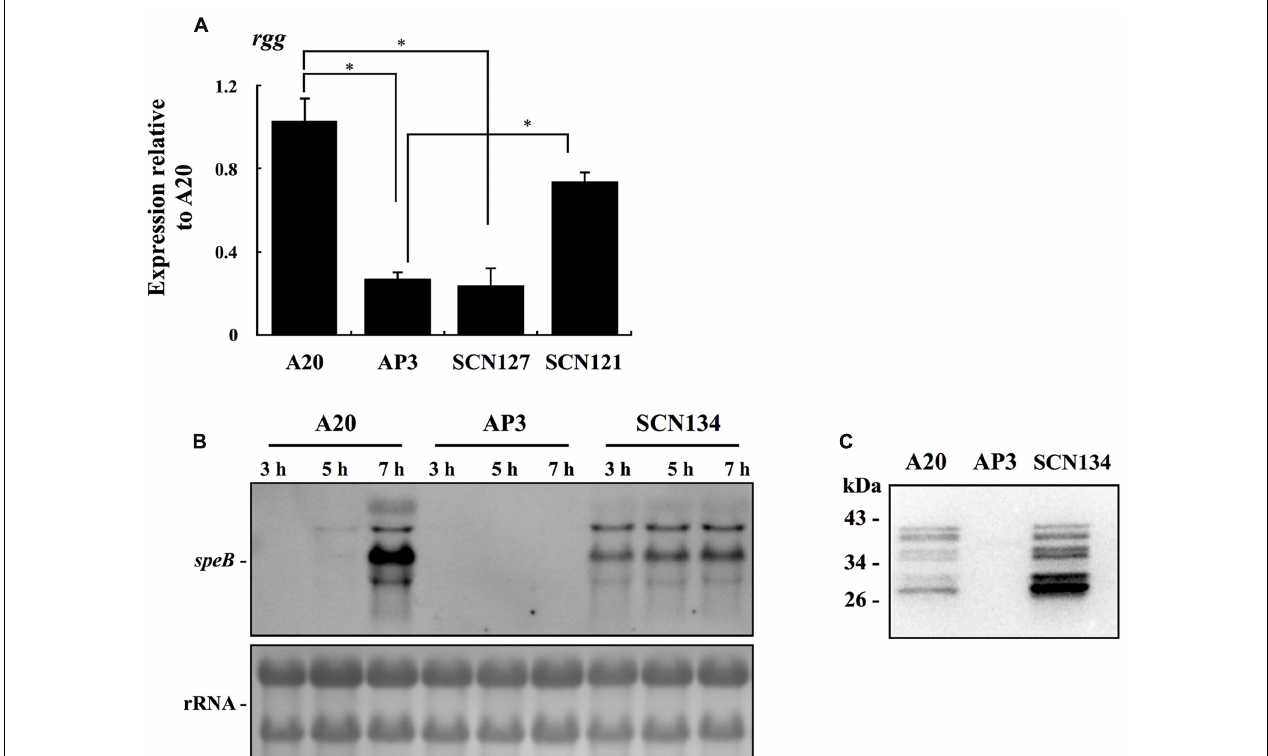
FIGURE 2 | The expression of rgg and speB in wild type A20 strain, covS mutant AP3, covR/S- complemented strain SCN121, vector control strain SCN127, and AP3 rgg overexpression strain SCN134. (A) The expression of rgg in A20, AP3, SCN127, and SCN121 in the stationary phase of growth. (B) The expression of speB in A20, AP3, and SCN134 in the early-exponential (3 h), late-exponential (5 h), and stationary phases (7 h) of growth. GAS strains were cultured in TSBY broth to different phases of growth and RNAs were extracted for Northern blot analysis. rRNA (lower panel) is used as the internal loading control. (C) The production of SpeB protein in A20, AP3, and SCN134. GAS strains were cultured in TSBY broth to the stationary phase of growth and 30 µ l of bacterial culture supernatants were subjected to Western blot analysis with the anti-SpeB